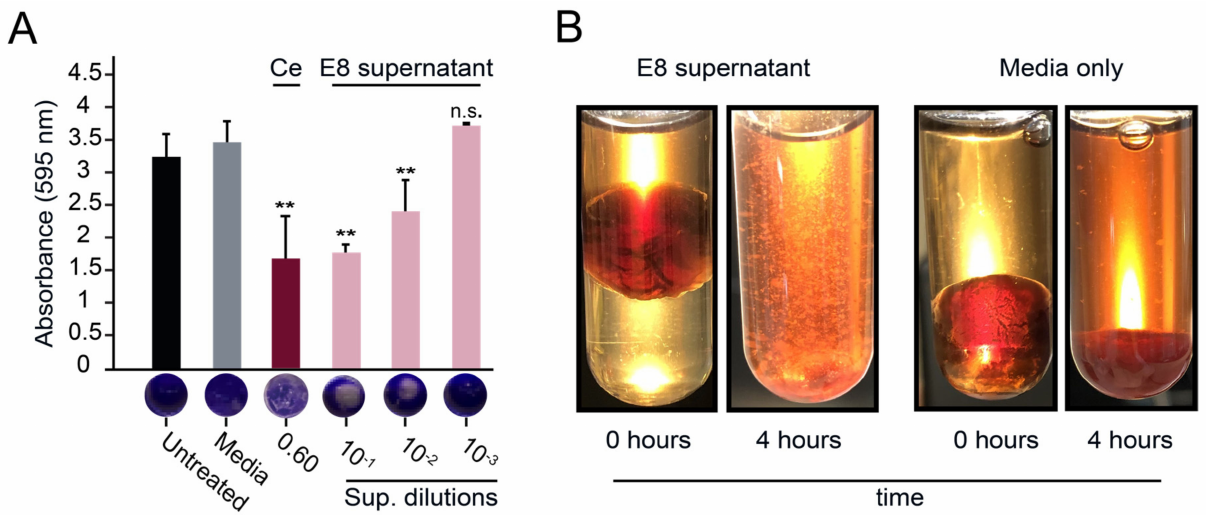
Figure 3. The biofilm-degrading properties of a P. pastoris culture supernatant containing an α - xylosidase from A. nidulans . ( A ) S. aureus biofilms were treated with spent media supernatant con- taining the E8 α -xylosidase and stained with crystal violet (Ce: commercial cellulase at 0.6 mg mL − 1 ) (n.s. = not significant, ** p < 0.01, Tukey’s test). ( B ) Clots formed using the Lubbock chronic wound model were visualized before (0 min) and after (4 h) incubation in undiluted culture media with or without the E8 α